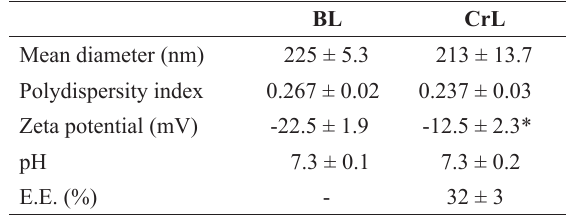
Characterization of BL and CrL.